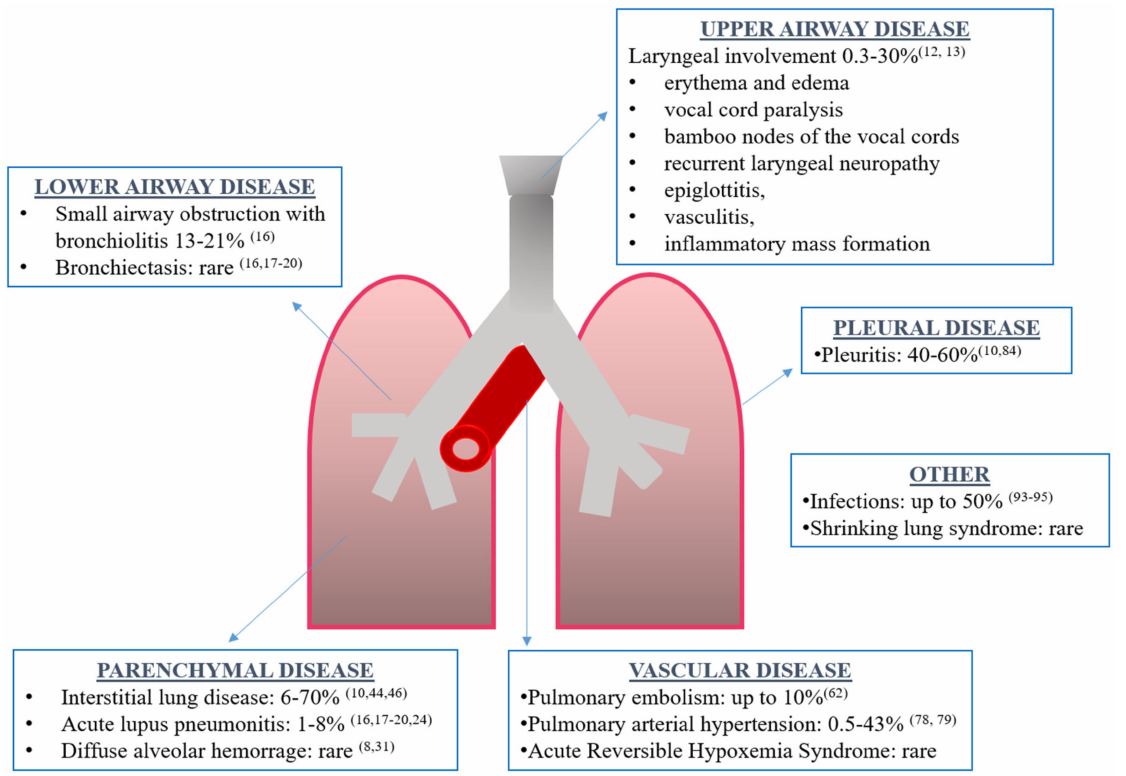
Figure 1. Overview of respiratory manifestations in systemic lupus erythematosus along with the prevalence and corre- sponding